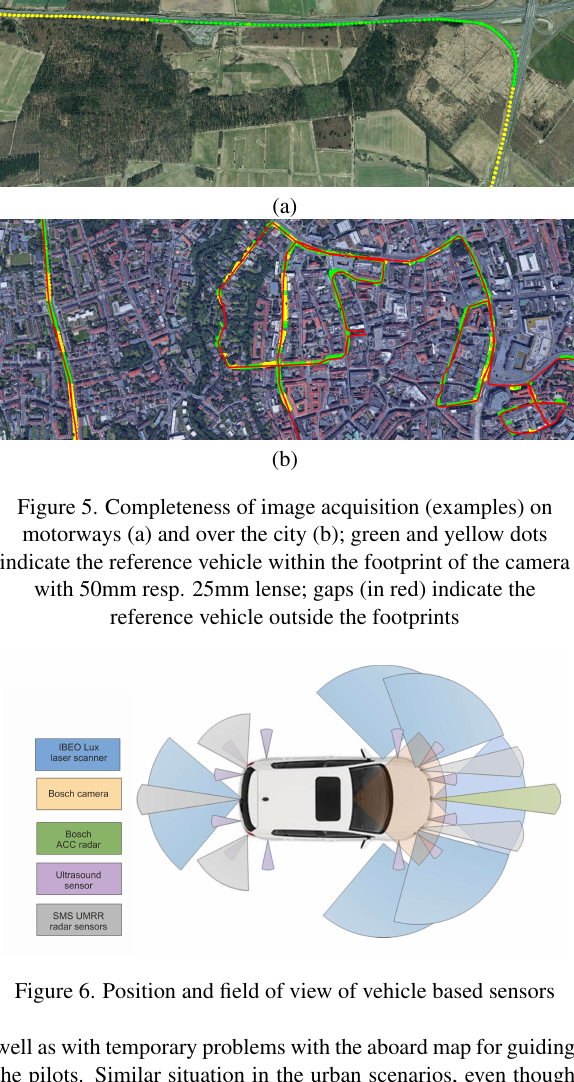
Figure 4. 4k sensor on Bo105 helicopter; (a) 4k sensor mounted on multi-purpose carrier, (b) sensor components, (c) viewing geometry and (d) footprints of the two cameras with focal length 50mm and 25mm